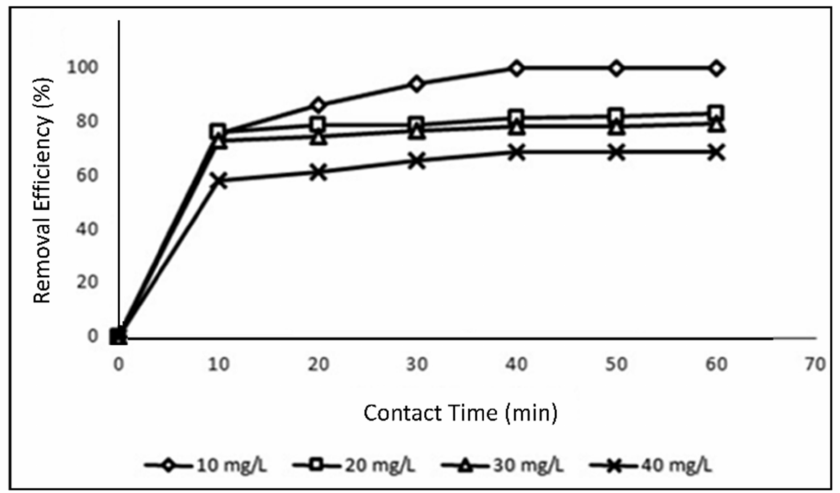
Figure 11. Effect of contact time on the effectiveness of methylene blue dye removal.